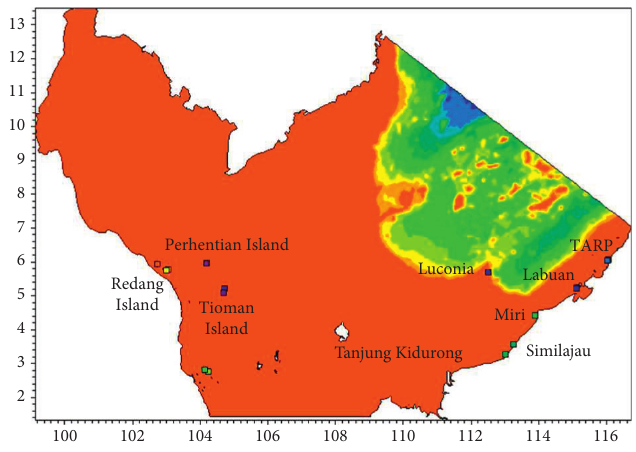
Figure 8: Coral spawning source